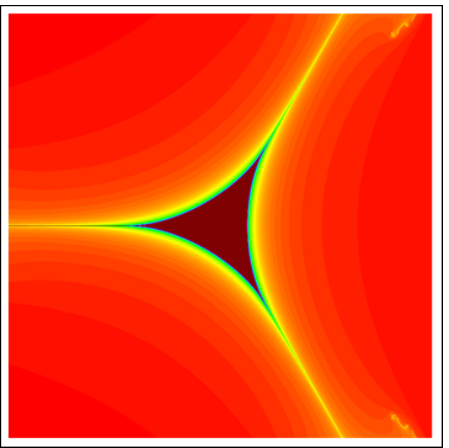
Figure 50. Tricorn via F-iteration with image visual time = 61.594 s.